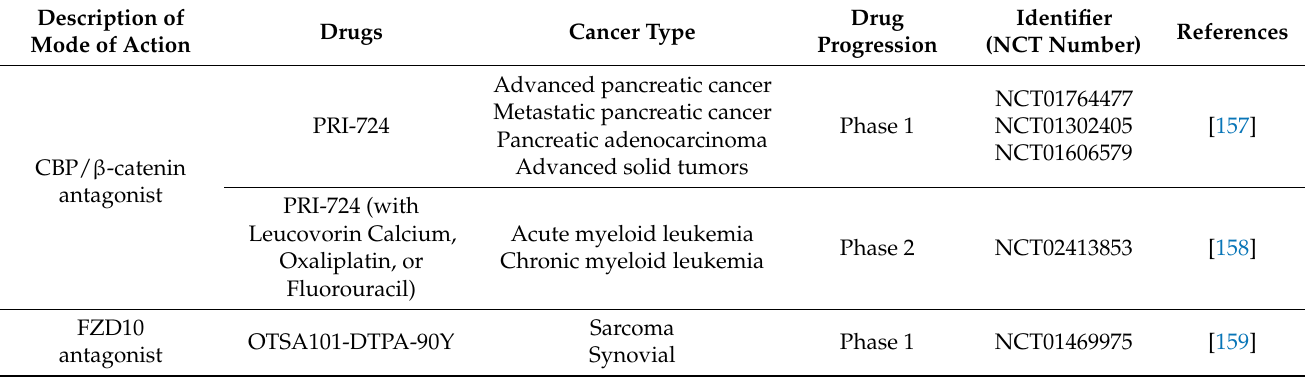
Table 5. Drugs of clinical trials for the components in Wnt/ β -catenin signaling